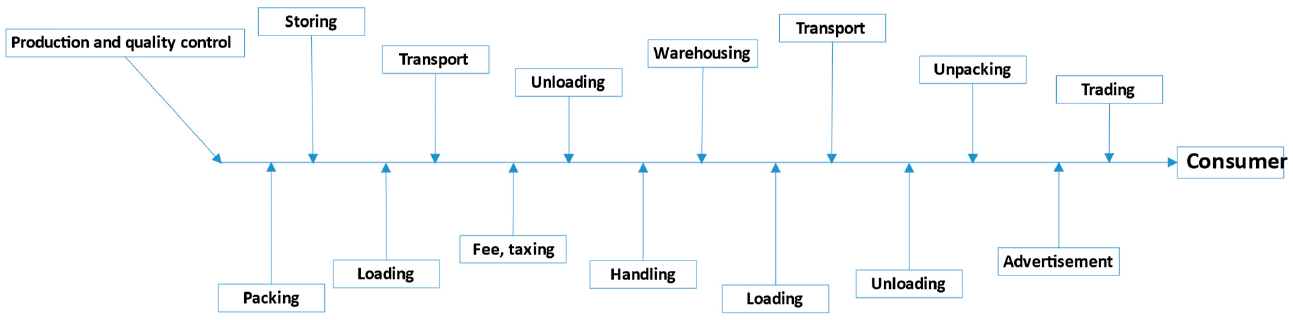
Figure 1. Diagram of basic logistics operations.